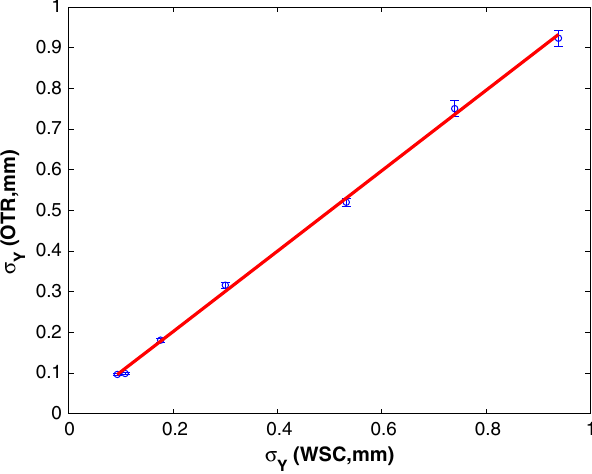
FIG. 6. Comparison OTR against WSC of beam profile measurements. The relative accuracy of a WSC measurement against OTR is within 2%. Beam energy 230 MeV, beam charge 160